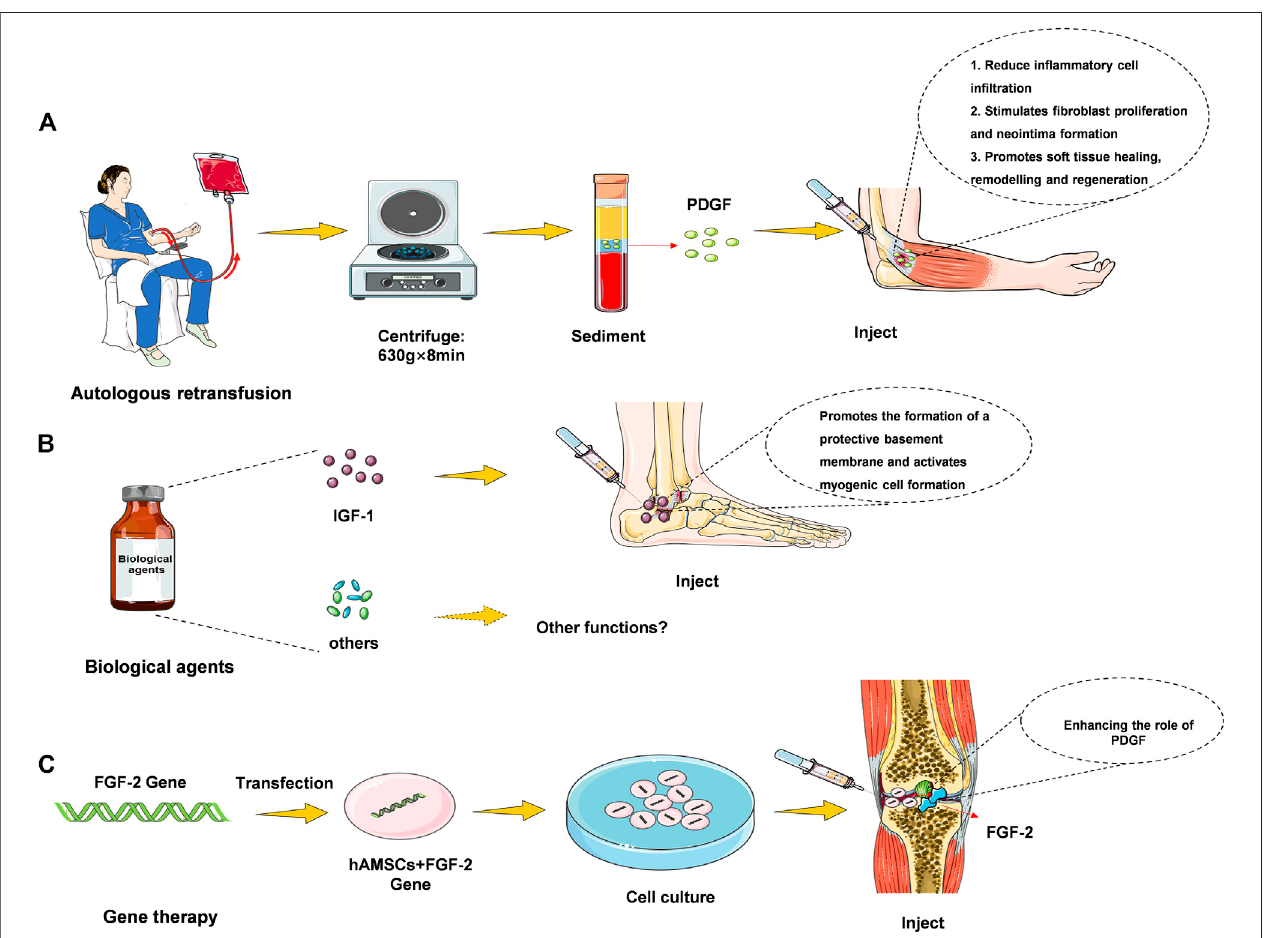
FIGURE 1 | Feasibility of growth factor preparation in the repair of sports